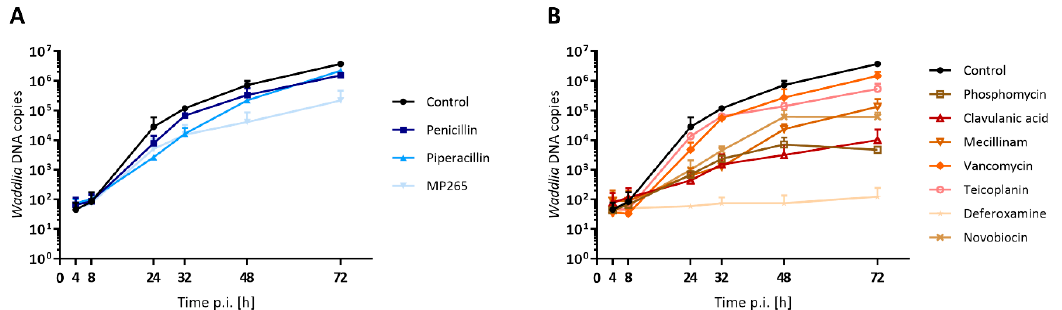
Figure 5. Stress stimuli treatments differentially affect W. chondrophila DNA replication. Vero cells were infected with W. chondrophila, and drugs were added at 2 hpi at concentrations indicated in Table 1. DNA was extracted at the indicated time points, and number of Waddlia DNA copies were quantified by qPCR. Error bars represent the SD of two independent experiments. Stress stimuli were grouped according to the ABs subtypes: ( A ) numerous and small ABs and ( B ) few and larger ABs. For each treatment, values at 48 and 72 hpi are significantly different ( p < 0.05) to the control condition, as determined by the one-way ANOVA test.